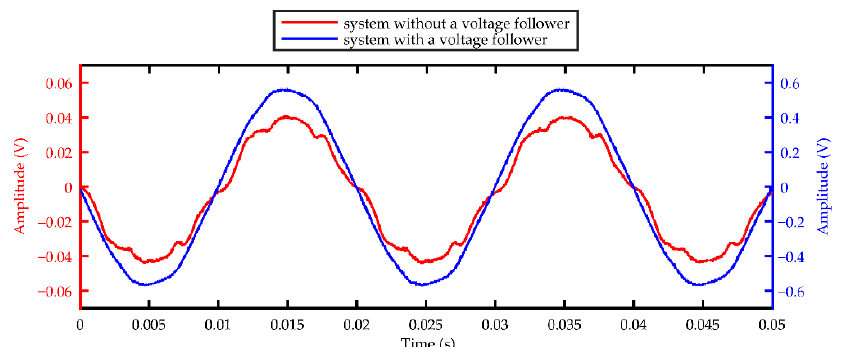
Figure 6. Comparison of voltage waveforms recorded in the system with and without a voltage follower.